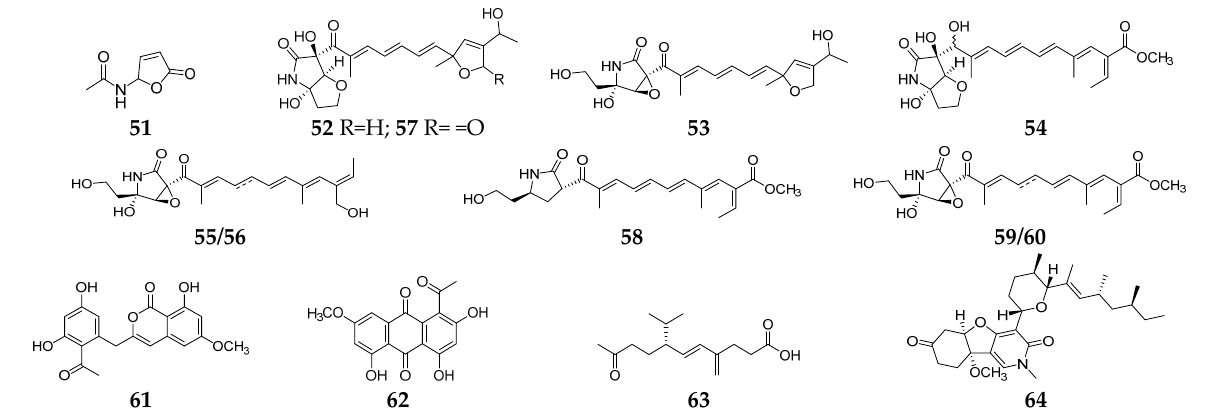
Figure 2. Fusarium -derived anti-Gram-negative bacterial SMs ( 51 – 64 ).